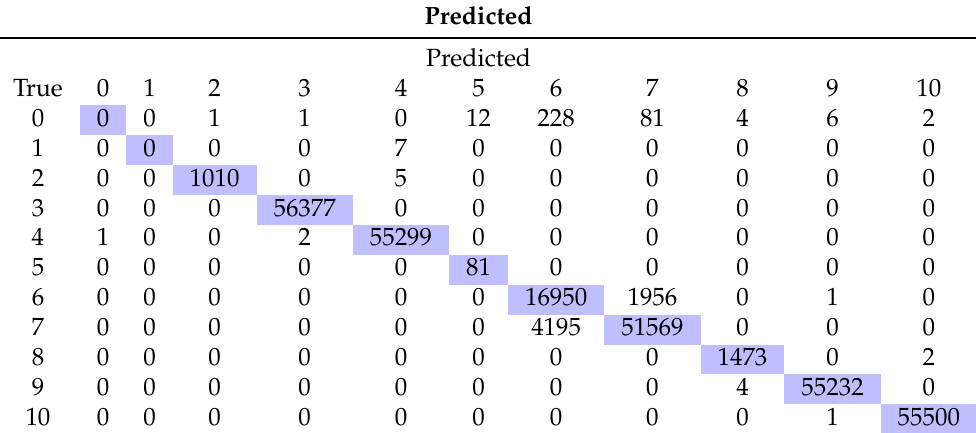
Table 51. ANN weighted classes confusion